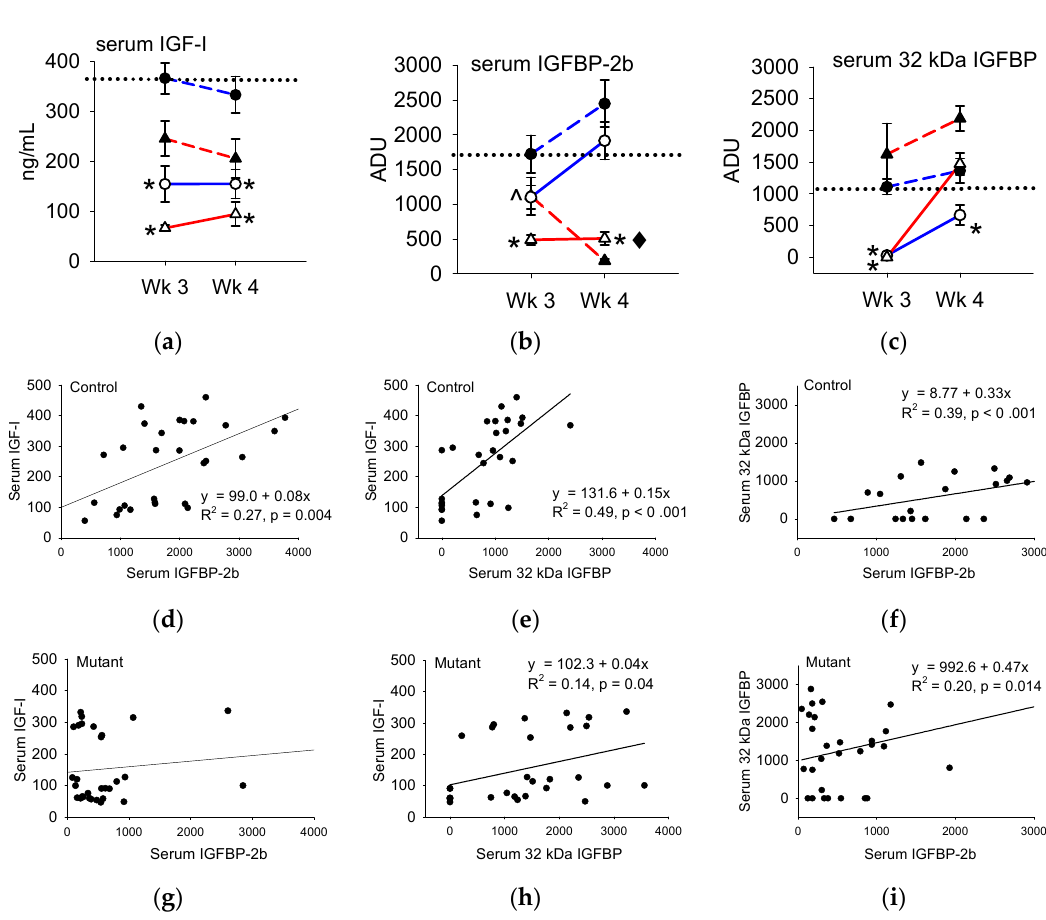
Figure 4. Abundance of serum ( a ) IGF-I, ( b ) IGFBP-2b, and ( c ) 32 kDa IGFBP during feed deprivation (FD, Wk 3) and refeeding (Wk 4). The horizontal dotted line is a visual reference for the mean of the continuously fed control fish at Wk 3. Asterisks indicate that the feed-deprived (dashed line) or refed groups (solid line) differ from continually fed fish within the same treatment group and week. The carrot (^) in panel ( b ) represents p = 0.06. The black diamond indicates that the magnitude of regulation from continually fed fish differs between the mutants and controls. Panels ( d ) through ( i ) represent associations between plasma variables in control ( d , e , f ) and mutant ( g , h , i ) fish. Trendlines indicate the regression of best fit; analysis data are provided when p < 0.05 ( n = 8).